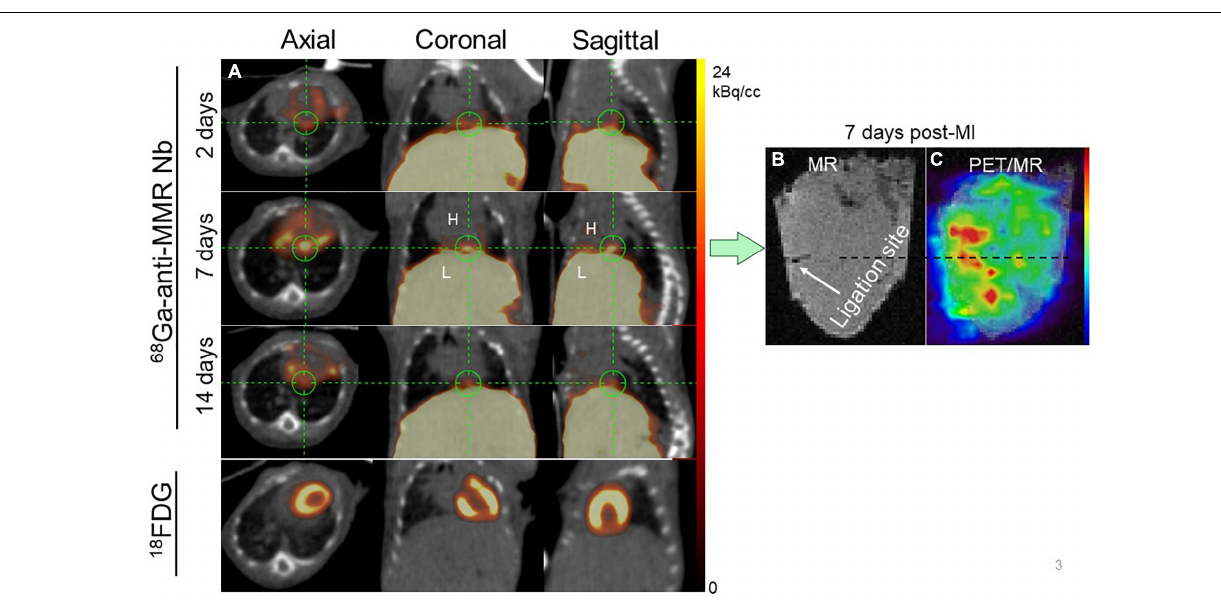
steady state (5,414 ± 427, 5,240 ± 817, and 5,405 ± 631 MFI, respectively) ( Figure 2C